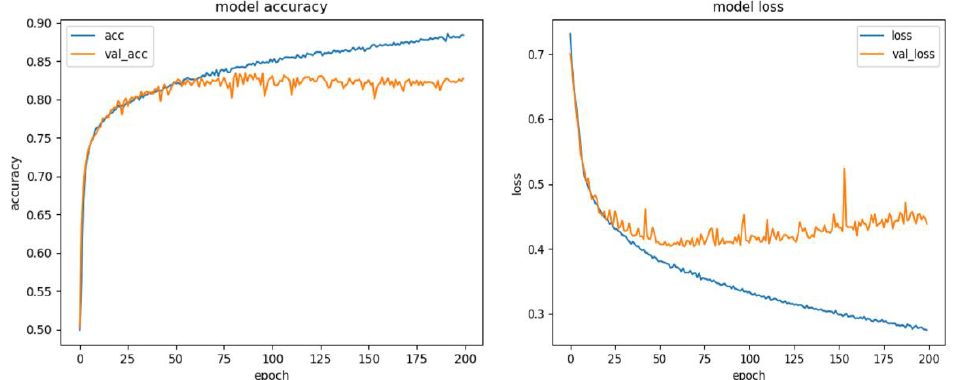
Figure 1. The model accuracy and the model loss of the ANN method. In the model accuracy distribution, acc denotes the correct rate of the training set and val_acc stands for the correct rate of the testing set. After 200 training runs, the highest correct rate in the experimental result achieves